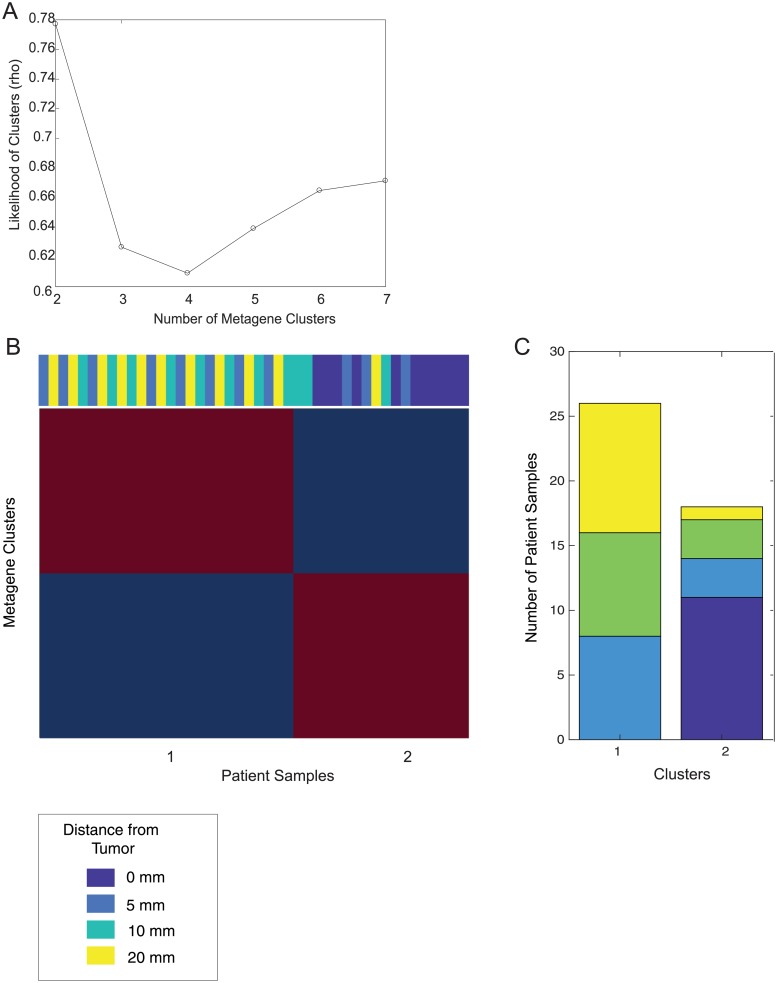
Unsupervised sample clustering using NMF.(A) Dispersal coefficients for sample clustering using 2, 3, 4, 5, 6 and 7 clusters. (B) Heatmap of metagene clusters with patient samples based on distance from tumor in color bar along the top. (C) The number of samples from each distance of tissue present in each metagene cluster.